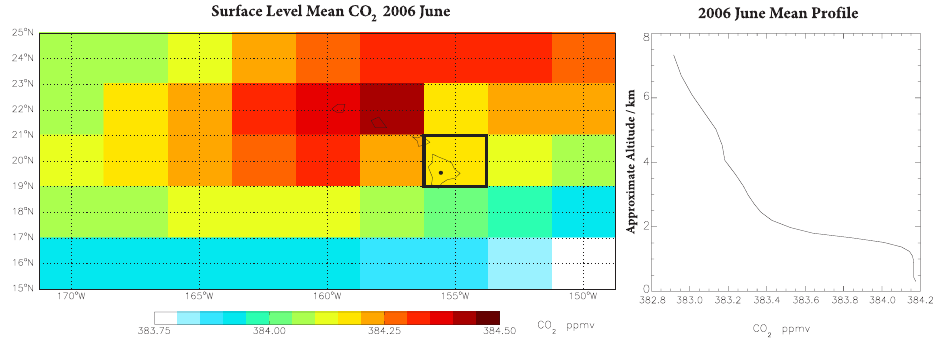
Fig. 12. GEOS-Chem mean surface level CO 2 for 2006 June for the Hawaiian Islands region (left). The CO 2 profile for the gridbox containing Mauna Loa (right) corresponds to the area outlined in black in the left panel. Altitude is only approximate for the profile because it is based on a conversion from model hybrid sigma levels which requires assuming a surface pressure that will vary throughout the gridbox (222km × 261km) from sea level to about 4.2km altitude. The location of the Mauna Loa observatory is shown by the black